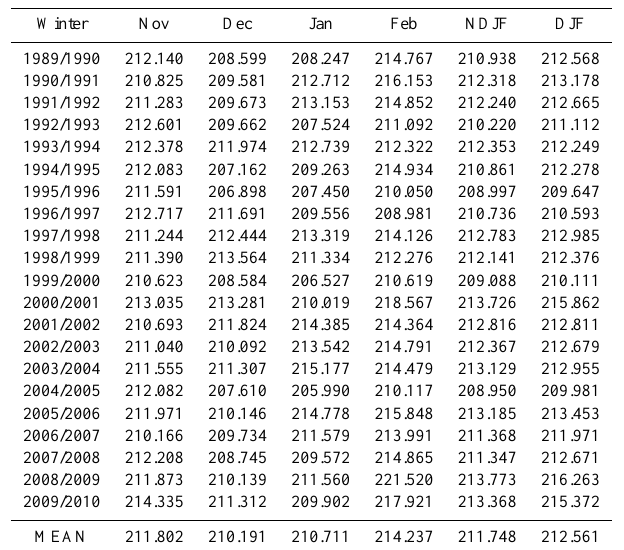
Table 2. Monthly mean polar cap (50 to 90 ◦ N) temperatures (K) at 50hPa calculated from the ERA-Interim data. Last two columns: Winter means from November to February and December to Febru- ary, respectively. Red (blue) colours denote unusually warm (cold) Arctic winter.